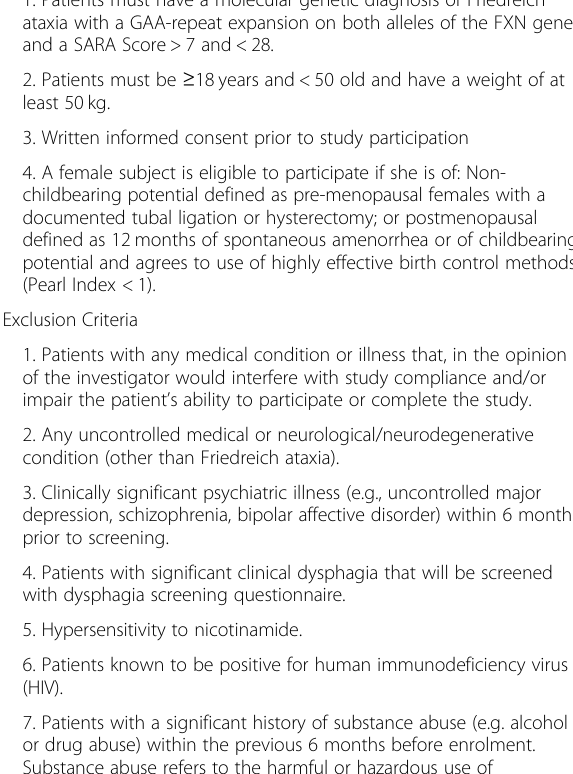
(Fig. 2, Table 2). The recruitment period will last 12